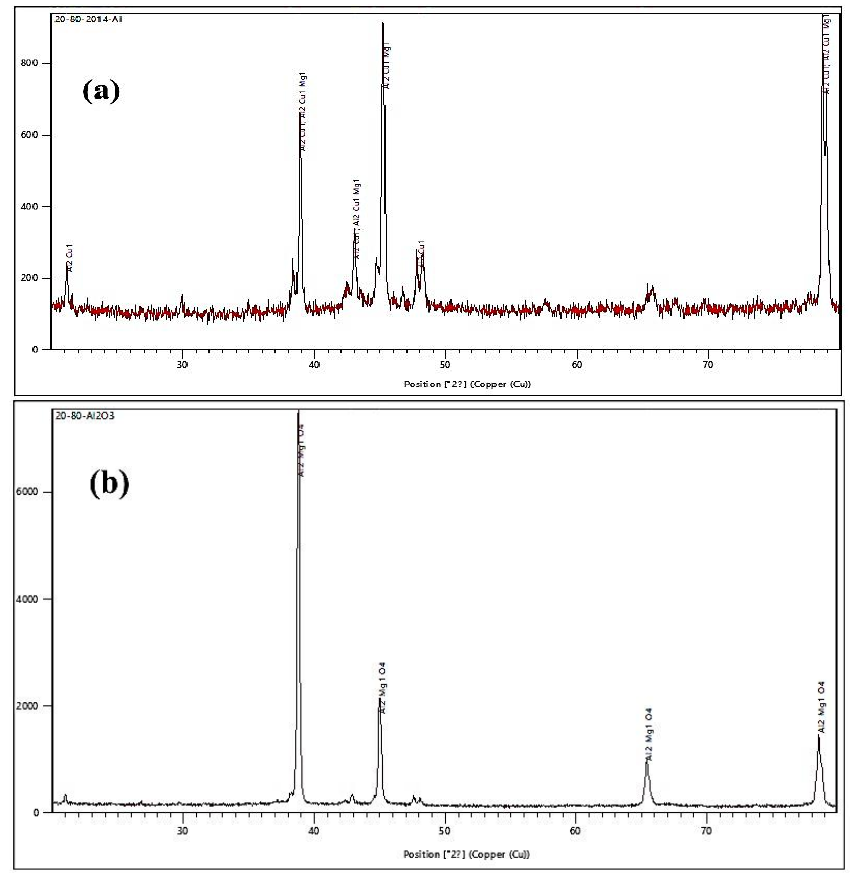
Figure 3. XRD pattern of ( a ) Al2014 after T6 heat treatment; ( b ) Al2014-15 wt.% Al 2 O 3 MMCs T6 heat treatment.